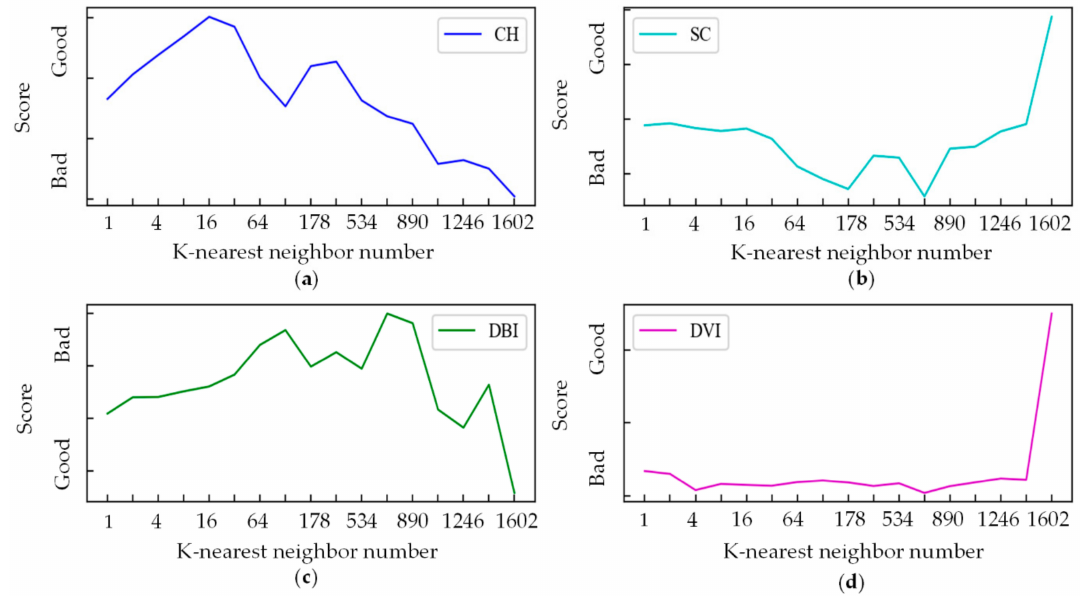
Figure 7. The influence of the K-nearest neighbor number on clustering. ( a ) CH index score; ( b ) SC score; ( c ) DBI score; ( d ) DVI score.